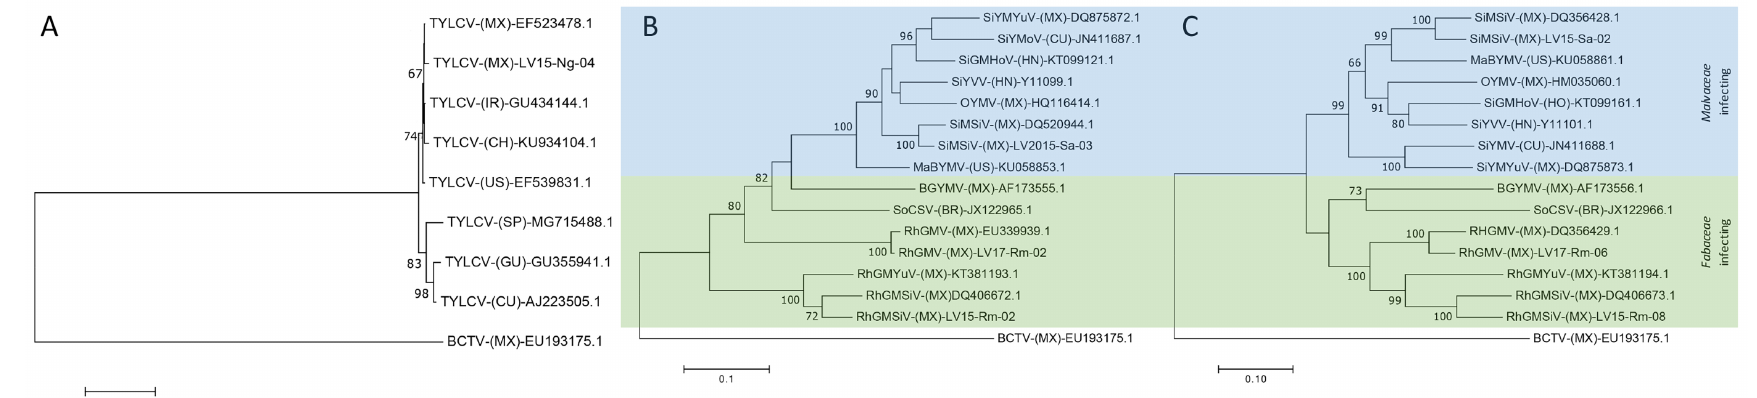
Figure 2. Phylogenetic trees based on multiple sequence alignment of complete monopartite ( A ) and bipartite begomovirus DNA-A ( B ), and DNA-B ( C ) with selected isolates obtained from NCBI. Trees were constructed by the maximum likelihood method with 1000 bootstrap replicates using MEGA7. Virus acronyms: Bean golden yellow mosaic virus (BGYMV), Malvastrum bright yellow mosaic virus (MaBYMV), Okra yellow mosaic virus (OYMV), Rhynchosia golden mosaic Sinaloa virus (RhGMSV), Rhynchosia golden mosaic virus (RhGMV), Rhynchosia golden mosaic Yucatan virus (RhGMYuV), Sida golden mosaic Honduras virus (SiGMHoV), Sida mosaic Sinaloa virus (SiMSiV), Sida yellow mottle virus (SiYMV), Sida yellow mosaic Yucatan virus (SiYMYuV), Sida yellow vein virus (SiYVV), Soybean chlorotic spot virus (SoCSV). Viral genomes Accession numbers are shown. Countries codes are as follow: Brazil (BR), Cuba (CU), Guatemala (GU), Ecuador (EC), Honduras (HN), Israel (IR), Mexico (MX), Puerto Rico (PR) and United States of America (US). As an out-group, Beet curly top virus sequence (BCTV) was used. Malvaceae and Fabaceae infecting virus are highlighted in blue and green,